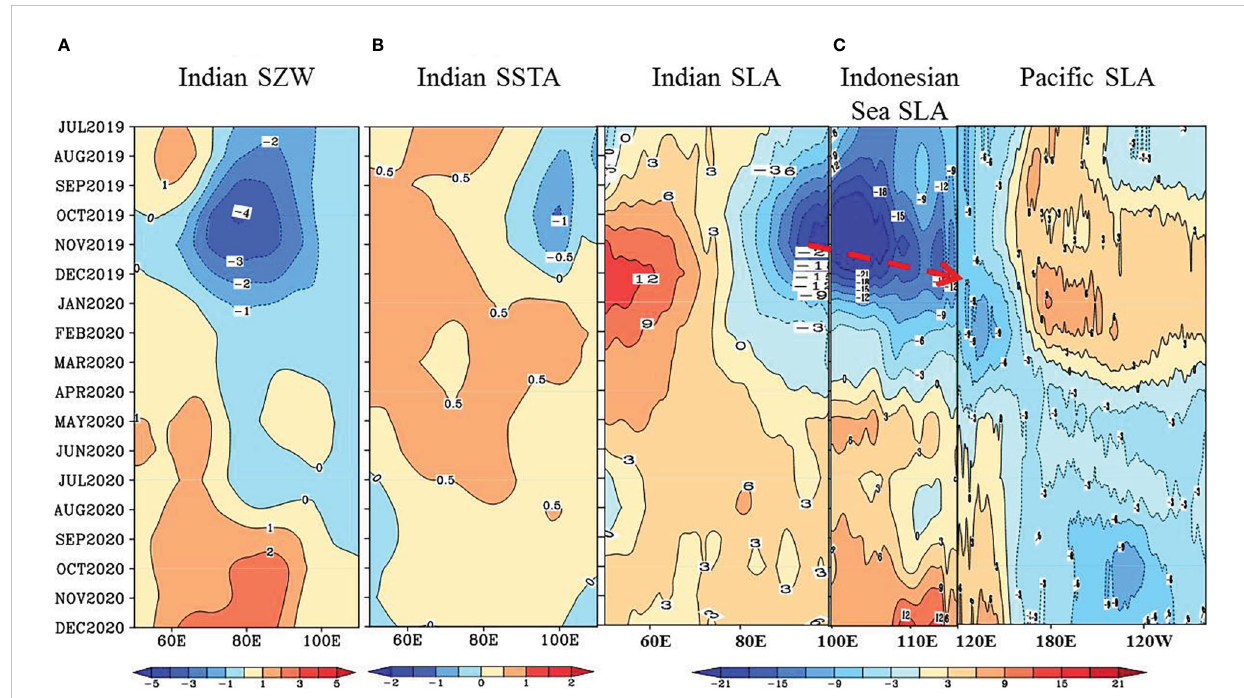
FIGURE 3 The “ oceanic channel ” dynamics of the 2020/21 La Nina predictability. Longitude-time plots of observed monthly anomalies of (A) surface zonal wind (SZW, m/s), (B) SSTA (°C) over the equatorial Indian and Paci fi c Ocean (5°S-5°N), and (C) SLA (cm) over the equatorial Indian and Paci fi c Ocean (1°S-1°N) and alongshore the Sumatra-Java island chain during the 2019 pIOD. The red dashed arrow indicates the eastward-propagating Kelvin